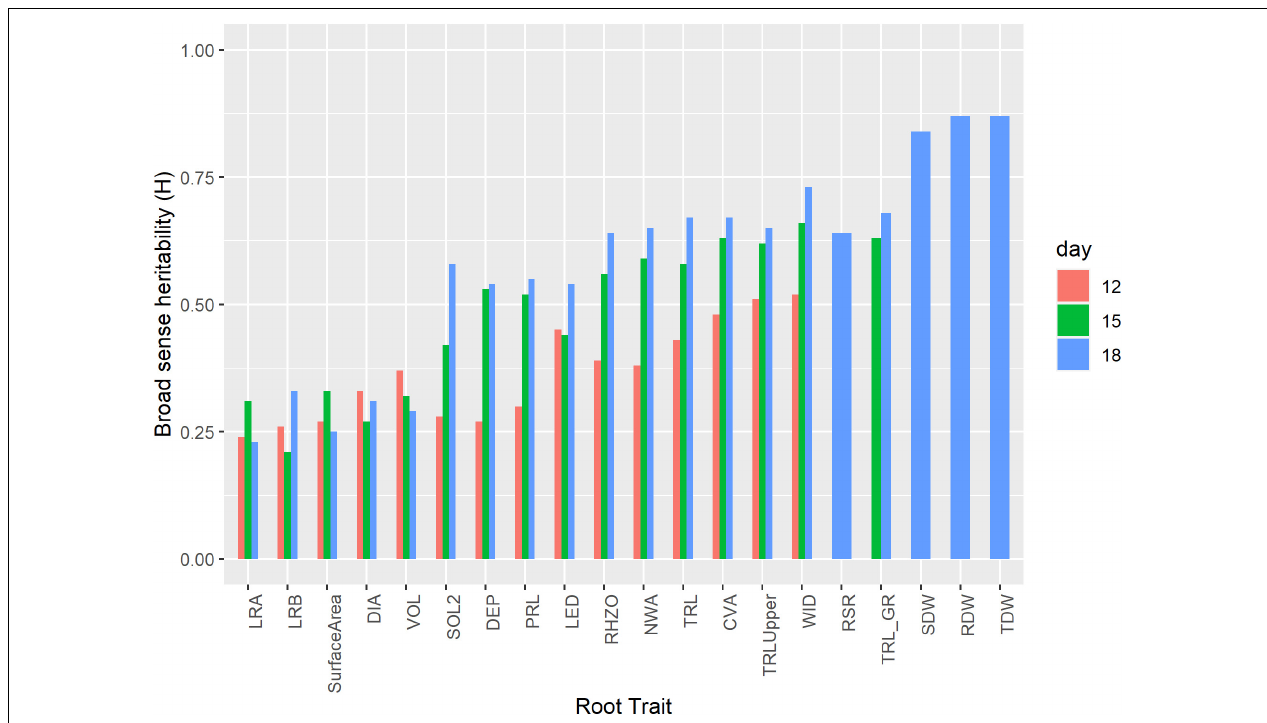
FIGURE 3 | Broad sense heritability (H) of select root related traits at days 12, 15, and 18. Experiments were carried out with the IA mung bean panel with genotypes grown in growth chambers.